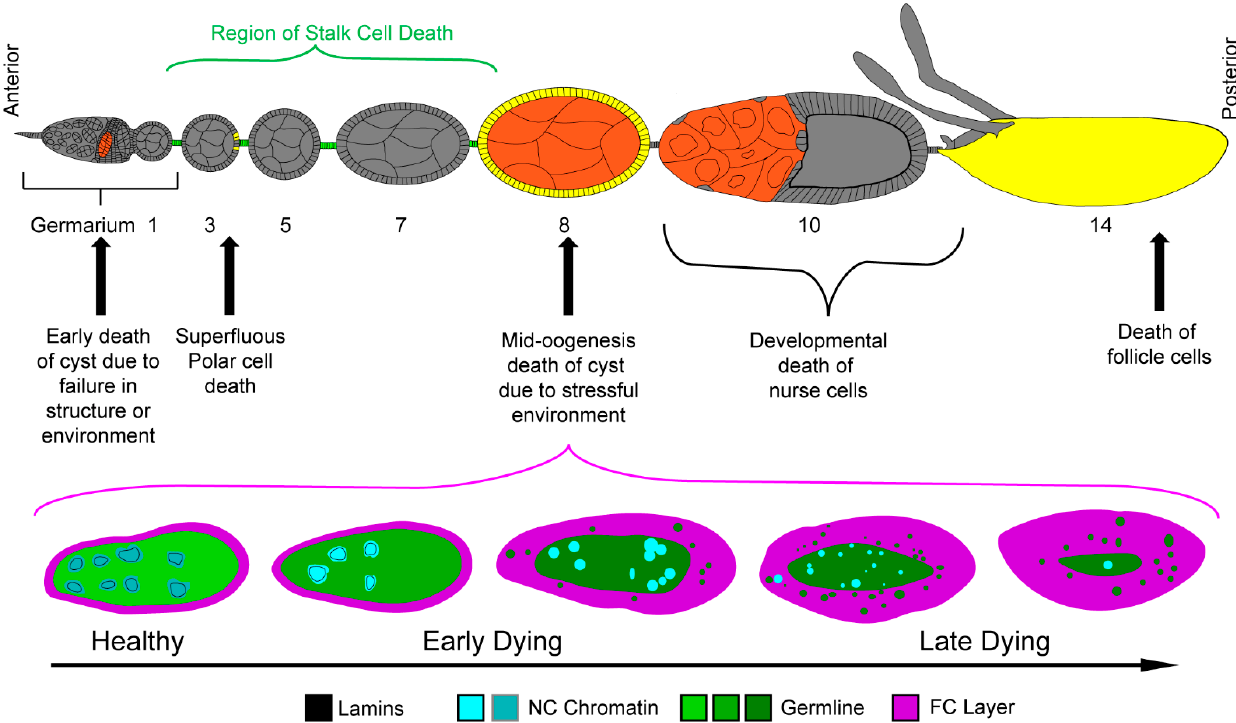
Figure 3. Cell death in oogenesis. Top—Schematic of ovariole with germline cell death events highlighted in orange and somatic cell death events highlighted in yellow and green. Bottom—Phases of cell death in egg chambers during mid-oogenesis are illustrated. Healthy egg chambers contain NCs with dispersed chromatin and intact nuclear lamina. The FC layer (magenta) surrounding the syncytium is thin, just 1 cell thick. As the germline dies, the chromatin condenses (as shown by the increasing brightness of the cyan) and the lamins are cleaved and become cytoplasmic (as shown by the germline green becoming darker). The chromatin condenses and fragments as germline cell death progresses. The follicle cells then efferocytose the germline material (green vesicles) to clear it